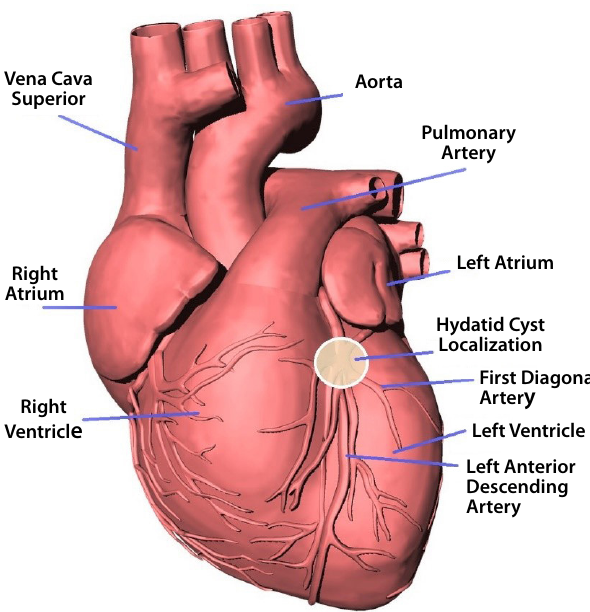
Fig. 2 – Localization of the intracoronary hydatid cyst.